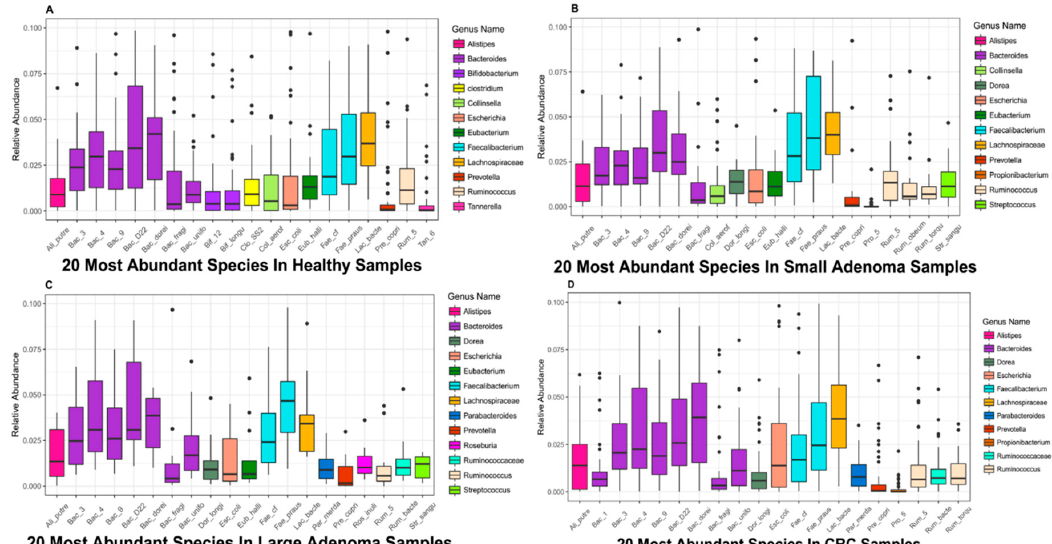
Figure 3. Top 20 microbial species with high relative abundance in samples of different disease stages. ( A ) The relative abundances of the top 20 microbes in the healthy samples. ( B ) The relative abundances of the top 20 microbes in small adenoma patients. ( C ) The relative abundances of the top 20 microbes in large adenoma patients. ( D ) The relative abundances of the top 20 microbes in colorectal cancer patients. The horizontal axis represents the abbreviation of the corresponding names of microbial species, the vertical axis represents the relative abundance of the corresponding microbes, and the different colored bars in the box plot indicate different microbial genera in Figure 3A–D.